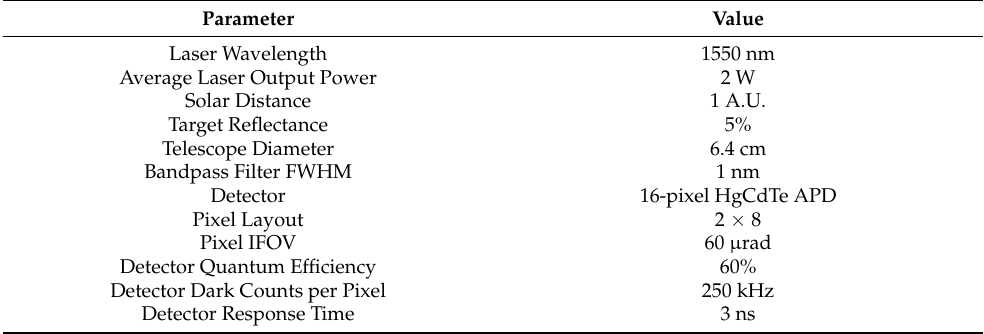
Figure 4. Selected samples from the performance simulation. All horizontal axes correspond to time in microseconds. ( A ) Transmitted PN code as a function of time. ( B ) Detector analog signal for a single code length prior to digitization is shown in red. The shorter blue signal corresponds to the range- shifted code. ( C ) Subset of ( B ) showing the individual photon detection events. The black, dotted line shows the threshold setting. ( D ) Digitized signal after the comparator stage. ( E ) Histogram of 154 accumulated digitized codes corresponding to a 10-ms integration time. ( F ) Cross-correlation of the histogram in ( E ) with the kernel, showing the correlation peak at 3.4 µ s. Table 2. Instrument and target parameters used in the performance simulations for the SALi